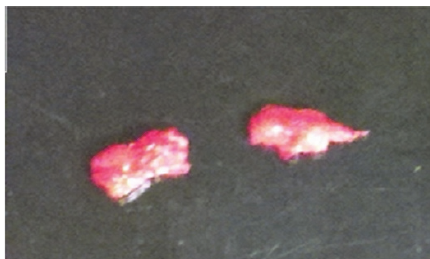
Figure 2: Intraoperative photograph demonstrates a large elongated softpink-tanthrombusexcisedfromtheleftventricle.Duetoitssize, the thrombus was extracted in 2